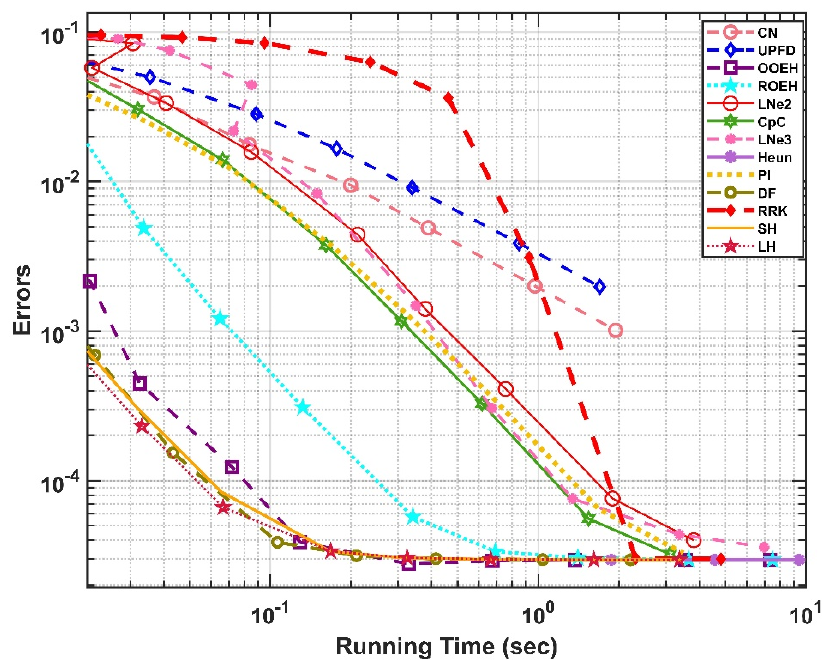
Figure 8. The maximum errors as a function of the running time for the abrupt change in the x -direction and gradual change in the z -direction.